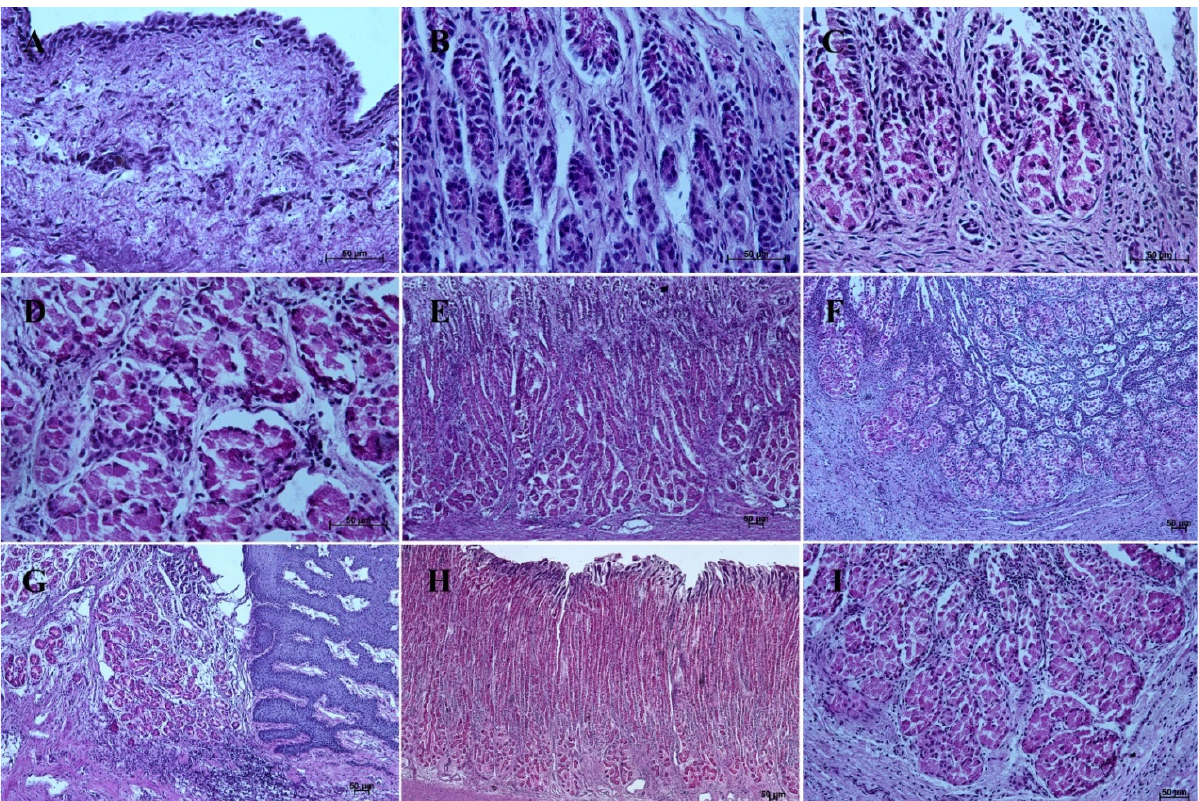
Figure 12. Histological structure of stomach mucosa in the glandular part (PAS staining). ( A )—the first age group (40×); ( B , C )—the beginning of mucus secretion by the gastric glands in the second age group (20× and 40×); ( D )—the cardiac glands in the third age group (40×); ( E )—the fundic glands in the third age group (20×); ( F )—the pyloric glands in the third age group (40×); ( G )—the cardiac glands in the reference adult group (10×); ( H )—the fundic glands in the reference adult group (5×); ( I )—the pyloric glands in the reference adult group (20×).